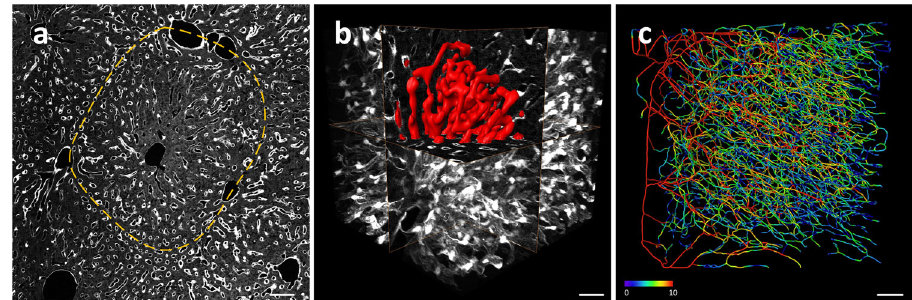
Fig. 4 Quantitative analysis of hepatic sinusoids. a A typical hepatic sinusoidal structure, marked by yellow dash-line. b The reconstruction of hepatic sinusoidal in the local area. c 3D visualization of sinusoid network, the diameter is encoded by different colors. Scale bar, 50 μ m ( a ), 20 μ m ( b , c ).Color bar, unit: μ m ( c